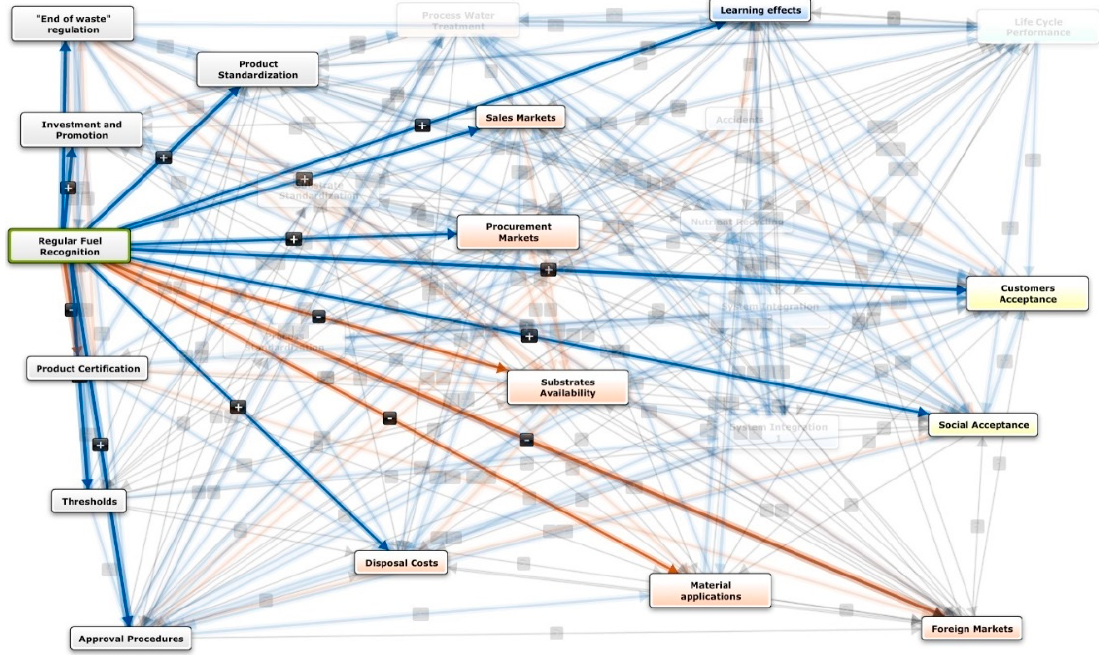
Figure 3. Part of the Fuzzy-logic Cognitive Map (FCM) for the impact of the concept “Regular Fuel Recognition” on other system concepts (expert knowledge-based FCM created with the Mental Modeler).